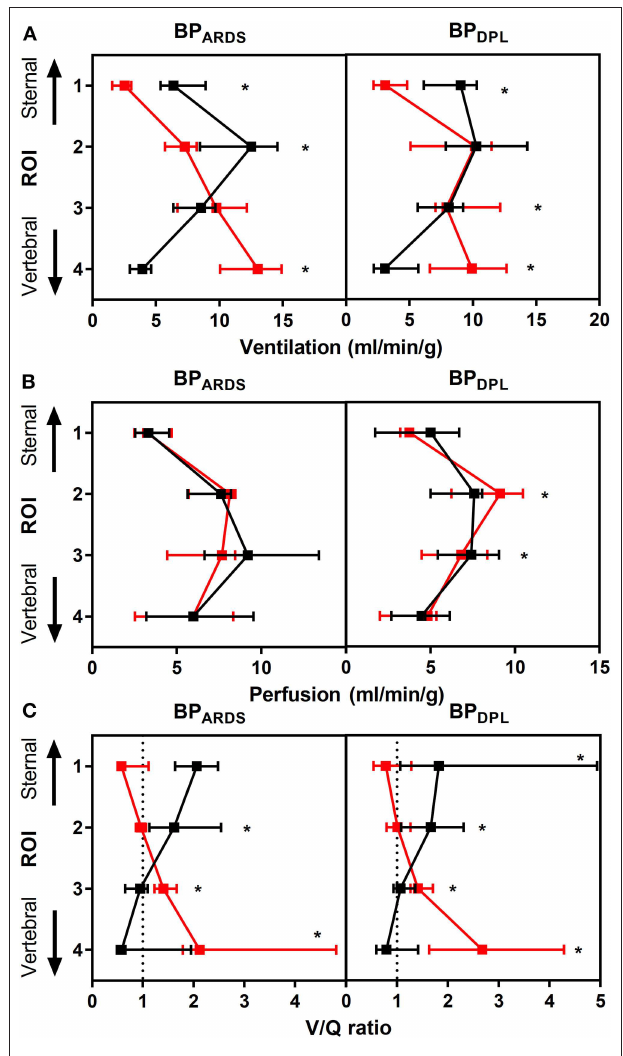
FIGURE 4 | EIT-derived ventilation (A) , perfusion (B) , and ventilation/perfusion ratio (C) data in supine (black dots) and prone (red dots) positions with PEEP set according to BP ARDS (left panels) and BP DPL (right panels). Data plotted as median (25–75th percentile). *Significant difference in the same ROI in prone vs. supine with p < 0.05. ROI: region of interest; EIT: electrical impedance tomography; PEEP: positive end-expiratory pressure; BP ARDS PEEP titrated according to the ARDS Network low PEEP/FiO 2 table; BP DPL PEEP set according to the lowest transpulmonary driving